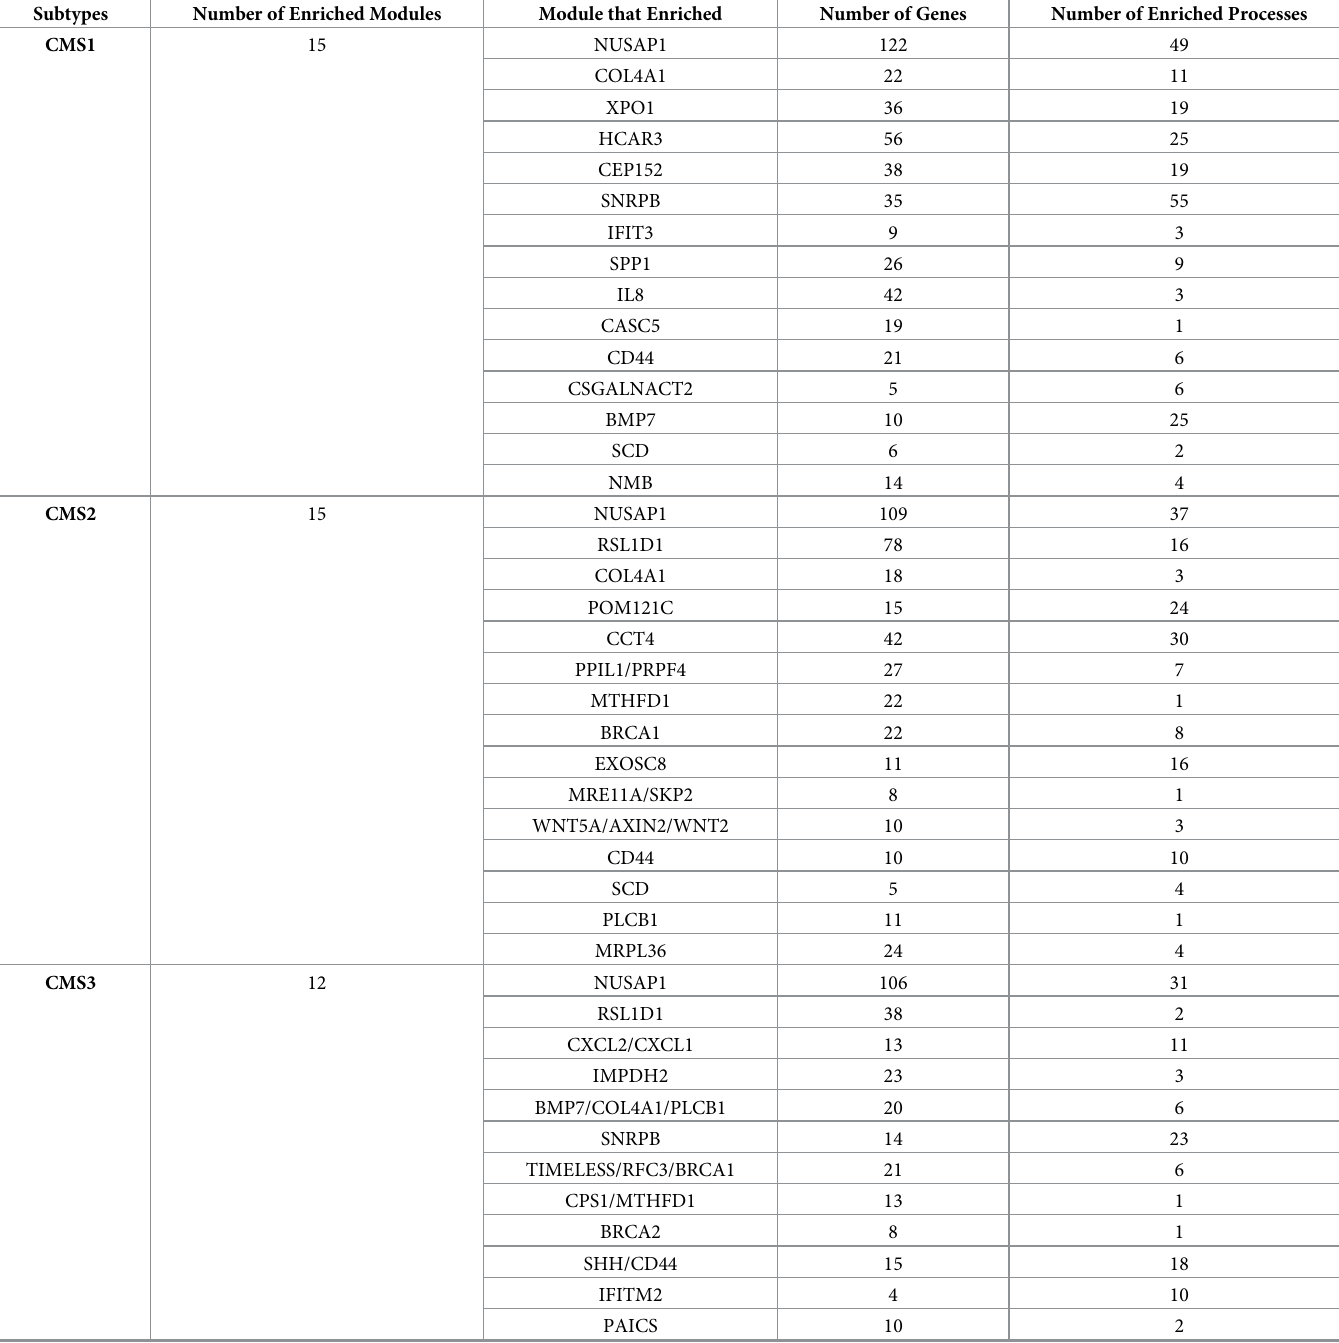
Table 2. Enriched modules (score > 3) found in each subtype